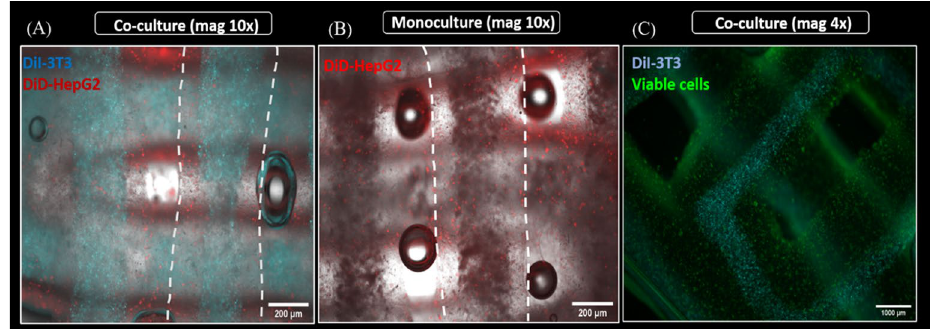
Figure 9. Spatially defined distribution of HepG2 and NIH 3T3 in core–shell strand scaffolds. ( A , B ) Fluorescence images of strands in a scaffold illustrating distribution of encapsulated cells in HepG2/NIH 3T3 co-culture vs. HepG2 monoculture scaffolds; scale bar 200 µm. White dashed lines indicate the whole strand width. ( C ) Fluorescence image of core–shell strand co-culture scaffolds showing Calcein-stained viable cells in green on day 4 of cultivation; for visualization of the core, the cyan channel (DiI-labeled NIH 3T3) was overlaid; scale bar 1000 µm.